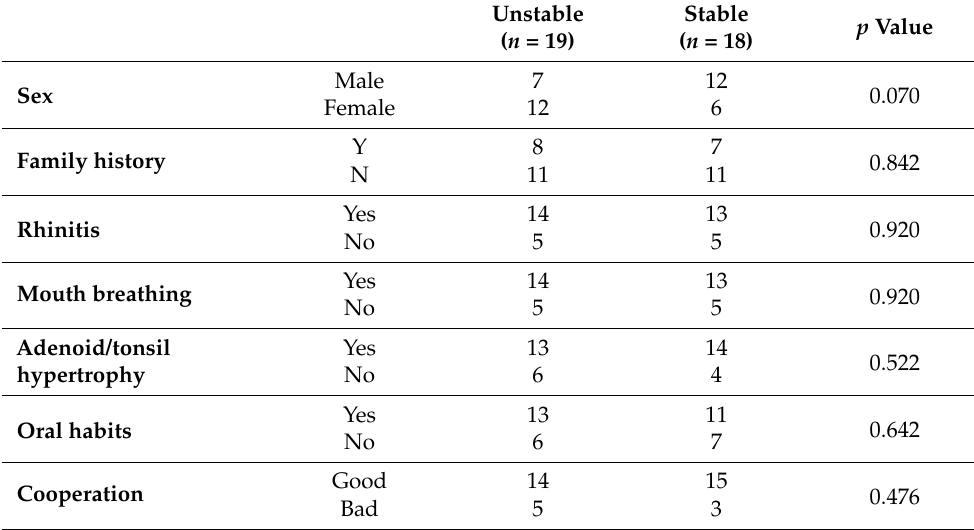
Table 3. Comparison of baseline characteristics between the stable and unstable groups.